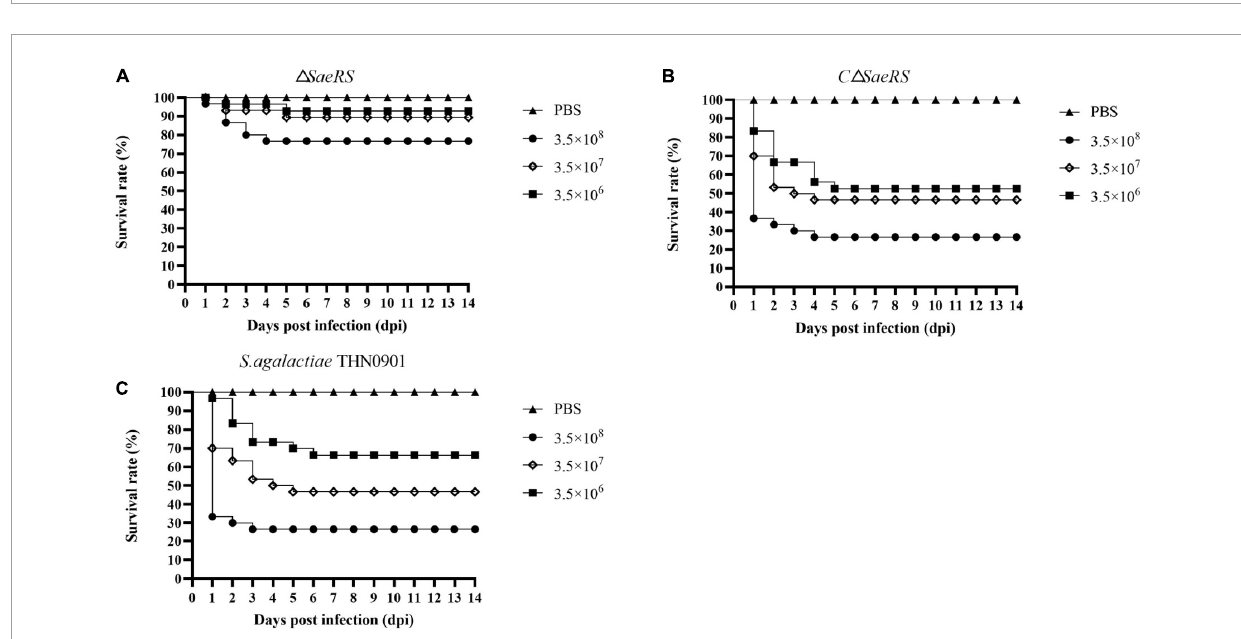
FIGURE5 Survival curves of tilapia ( Oreochromis niloticus ) after intraperitoneal infection of S. agalactiae with three strains at the same dose. The mutant strain (cid:49) SaeRS (A) . The complementary strain C (cid:49) SaeRS (B) . The wild-type strain THN0901 (C)